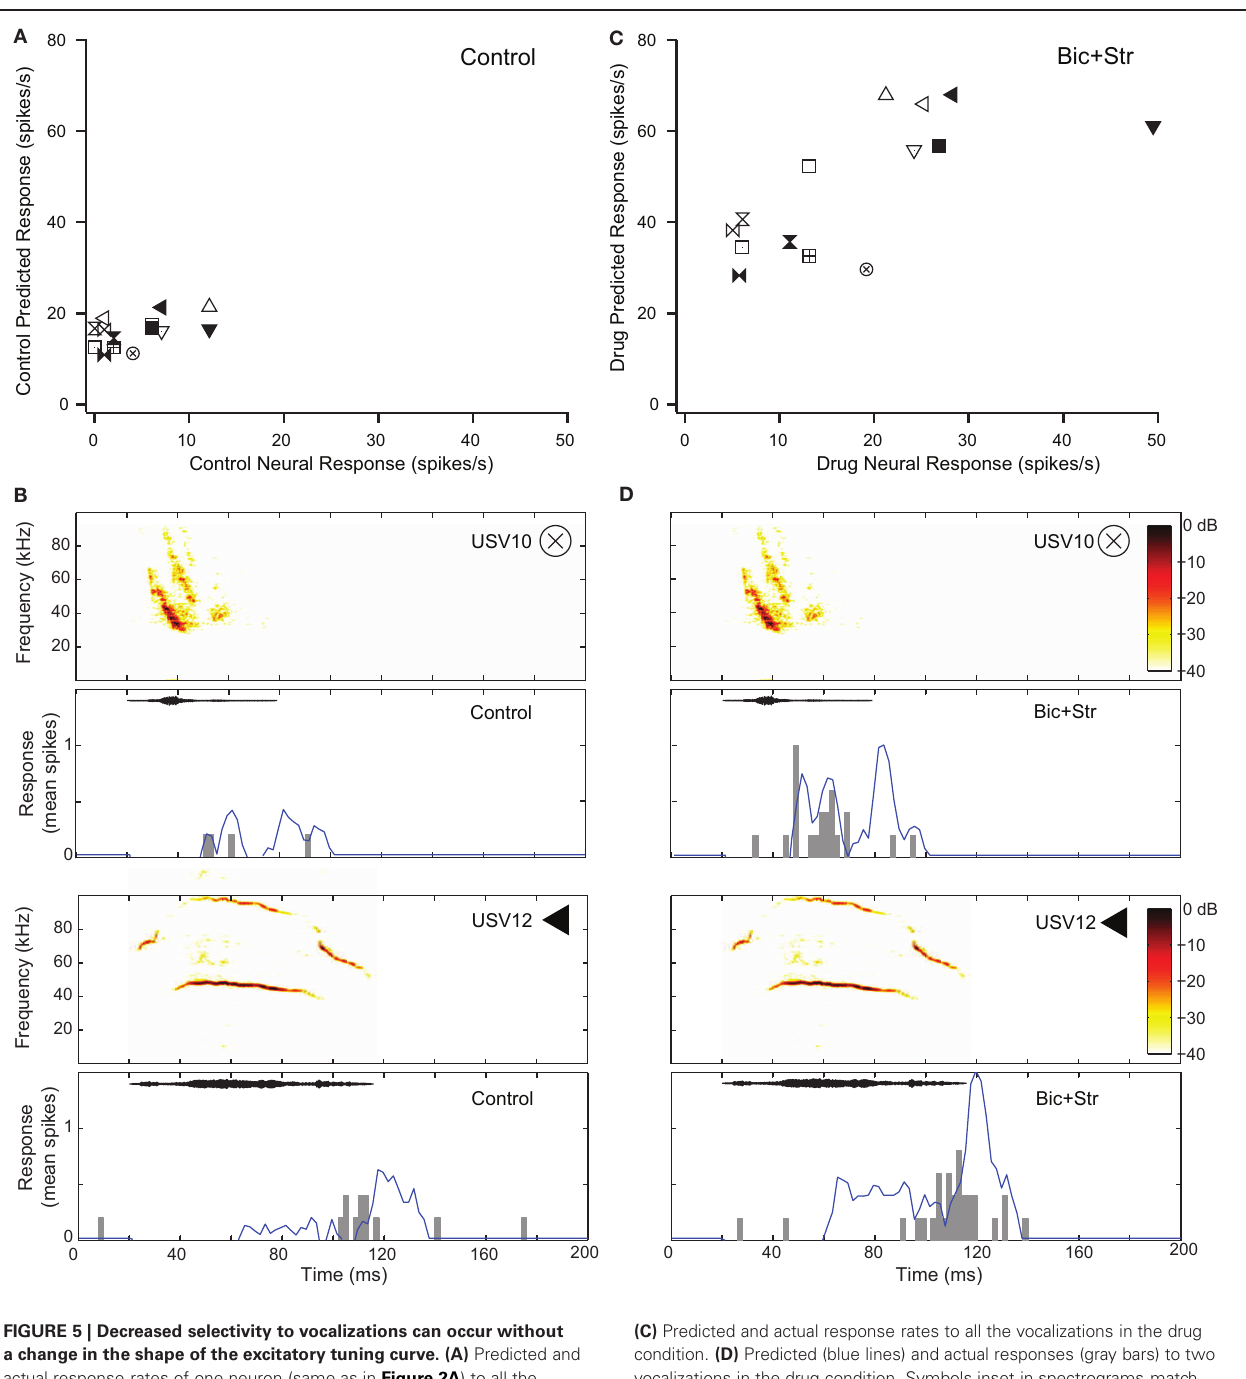
FIGURE 5 | Decreased selectivity to vocalizations can occur without a change in the shape of the excitatory tuning curve. (A) Predicted and actual response rates of one neuron (same as in Figure 2A ) to all the vocalizations in the control condition. (B) Predicted (blue lines) and actual responses (gray bars) to two vocalizations in the control condition.